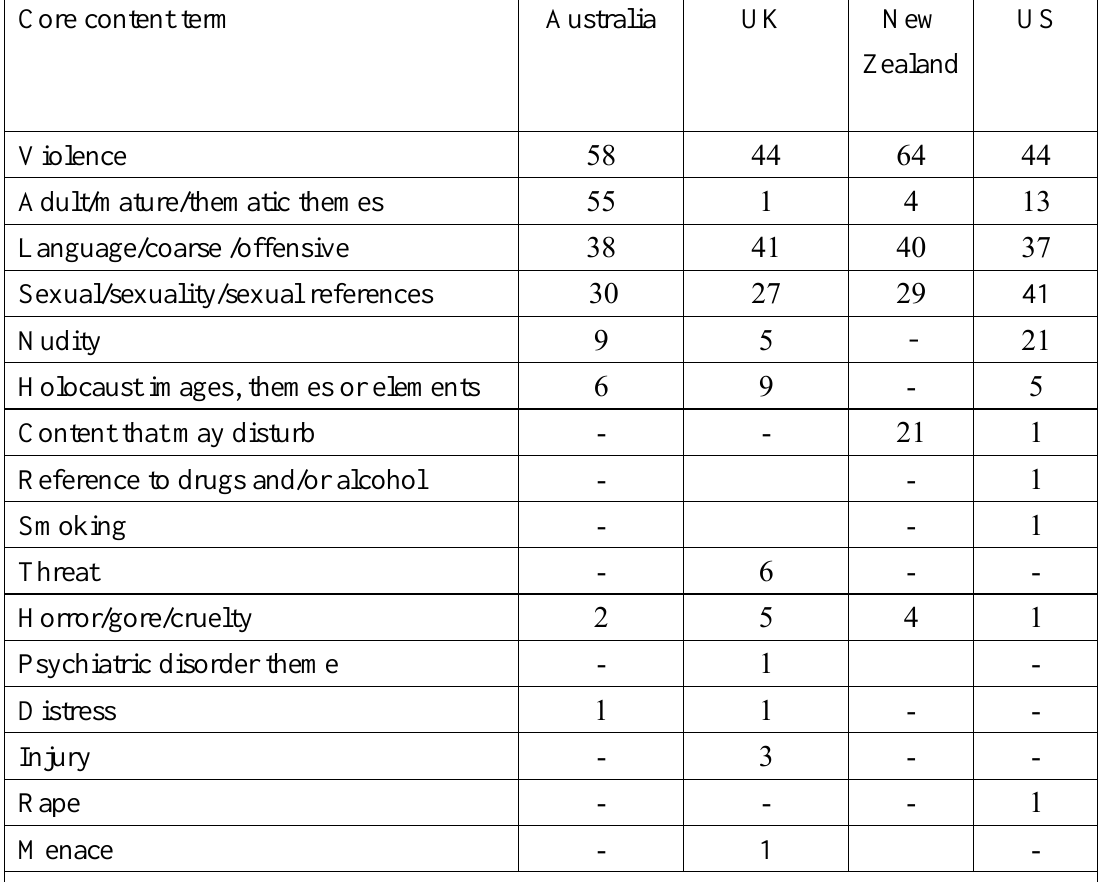
Table 3 Distribution of core content terms across